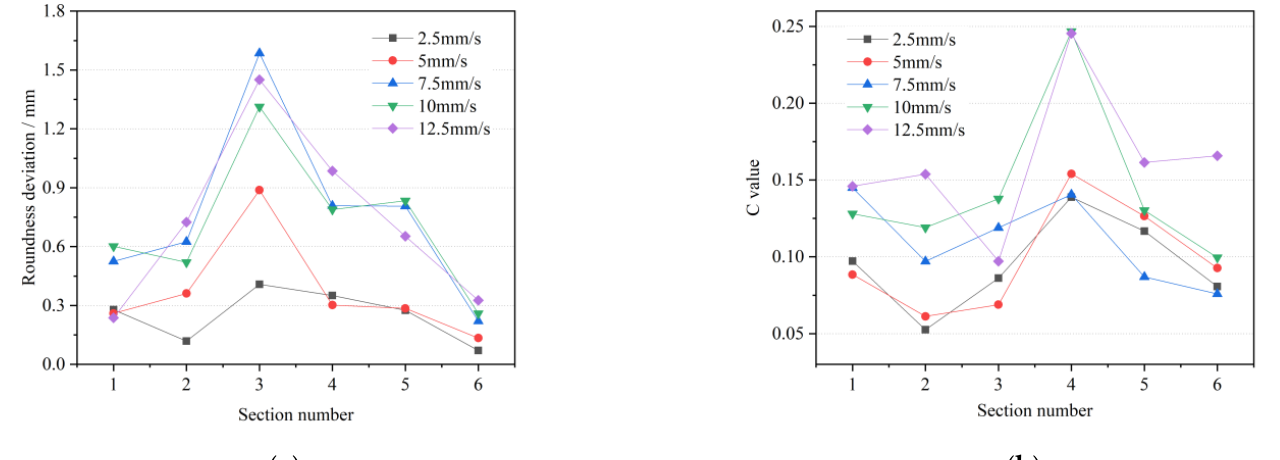
Figure 11. Forming quality under different roll feed speeds ( a ) roundness deviation; ( b ) wall thickness uniformity.